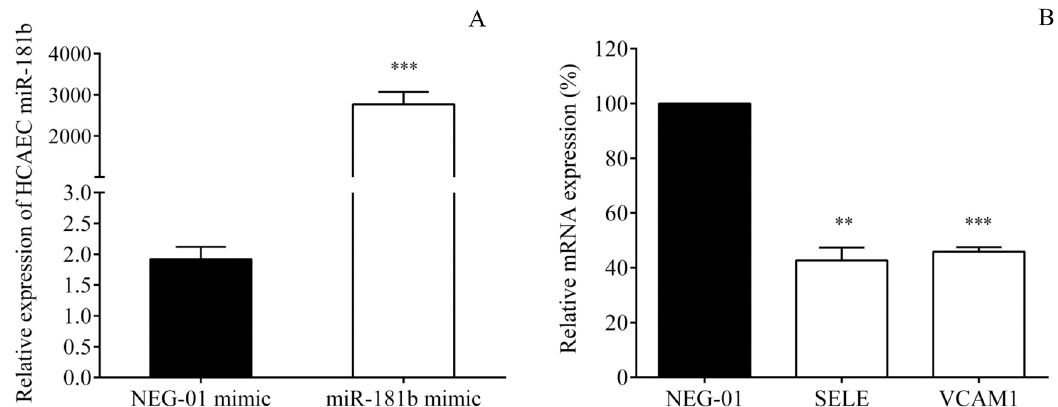
Fig 6. Overexpression of miR-181b altered the levels of SELE and VCAM1 mRNA in HCAECs. The direct association between miR-181b and SELE/VCAM1 was investigated in HCAECs after stimulation with TNF- α by using transfection of mirVana 1 miR- 181b mimics (25 pmol) with Lipofectamine RNAiMAX 1 Transfection Reagent for 24 hours. In parallel, negative control samples were treated with mirVana 1 miRNA mimic negative control (NEG-01, 25 pmol). After transfection, miR-181b with SELE and VCAM1 mRNAs were quantified by RT-qPCR. Highly increased miR-181b levels (A) resulted in significantly lowered SELE and VCAM1 mRNAs compared to NEG-01 control samples (100%, B). (cid:3)(cid:3) P = 0.006, (cid:3)(cid:3)(cid:3) P < 0.001 based on t-test. Mean ± SEM, n = 4/